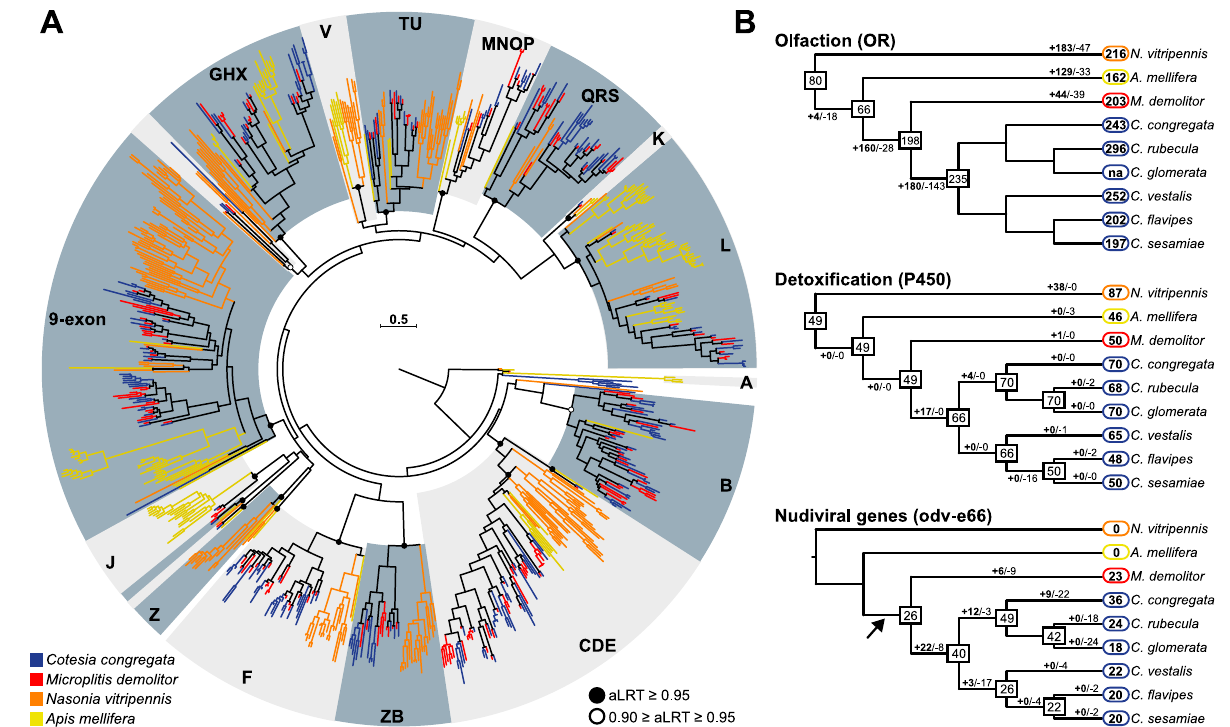
Fig. 2 Gene family extensions in Cotesia . A Maximum-likelihood phylogeny of the OR family in C. congregata and four other Hymenoptera species. The dataset included 243 amino acid sequences from C. congregata (blue), 203 sequences from M. demolitor (red), 216 sequences from N. vitripennis (orange), 162 sequences from A. mellifera (yellow). The tree was rooted using the Orco (OR-coreceptor) clade. Circles indicate nodes strongly supported by the approximate likelihood-ratio test (black circles aLRT ≥ 0.95; white circles 0.90 ≥ aLRT ≤ 0.95). The scale bar represents 0.5 expected amino acid substitutions per site. ORs of the fi ve Hymenoptera species are distributed into 18 OR subfamilies previously described in 18 delineated in gray. B Copy number dynamics of OR (olfaction) P450 (detoxi fi cation) and Odv-e66 genes, note that the later are found speci fi cally in bracovirus-associated wasps since they derive from the ancestrally integrated nudivirus. Estimated numbers of gene gain and loss events are shown on each branch of the species tree. The size of OR repertoires in common ancestors is indicated in the boxes. The lack of phylogenetic resolution for closely related Cotesia OR genes precluded any comprehensive analysis of gene gains and